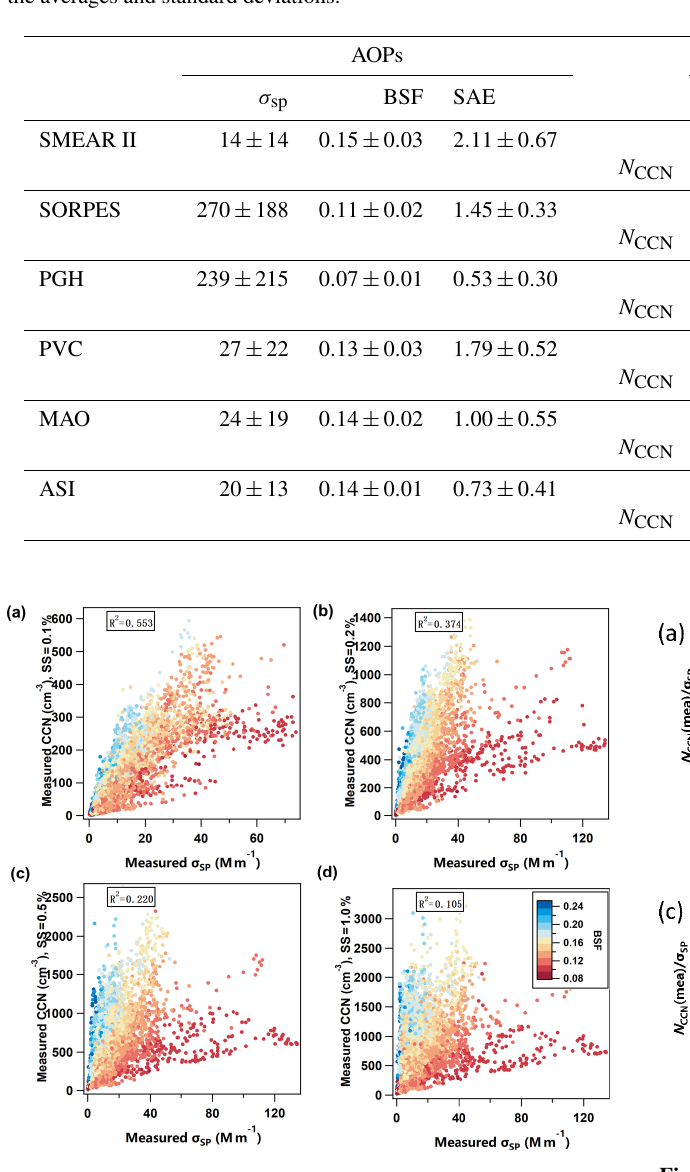
Figure 2. Measured CCN number concentration N CCN (meas) vs. PM 10 scattering coefficient σ sp at λ = 550nm at SMEAR II at four supersaturations (SS): (a) 0.1 %, (b) 0.2 %, (c) 0.5%, and (d) 1.0%. Color coding: backscatter fraction (BSF) at λ = 550nm.